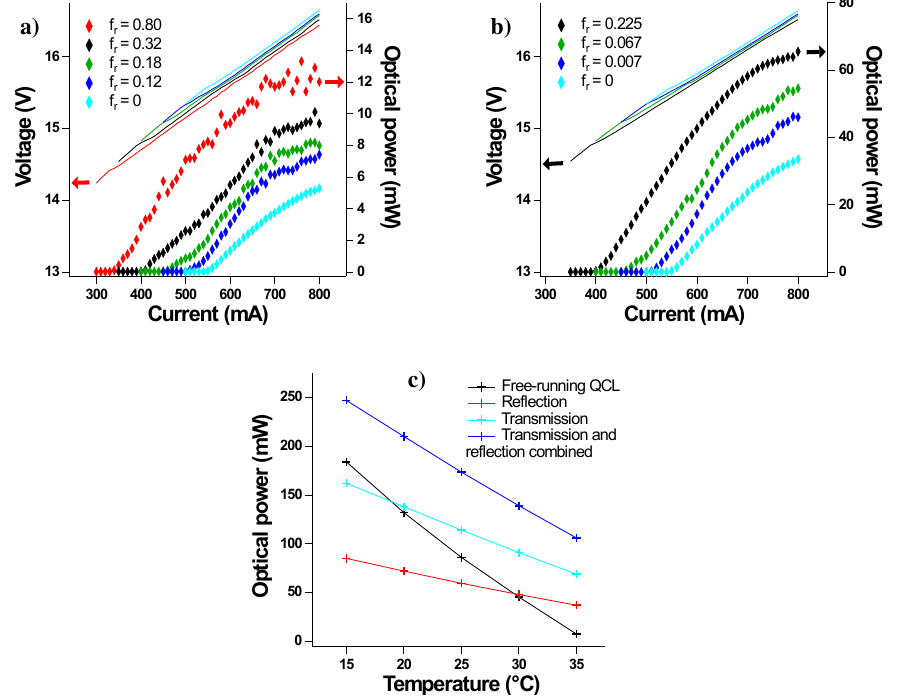
Figure 2. Analysis of the optical power emitted by the packaged QCL. ( a ) The LIV characteristic of the QCL under optical reinjection when using the platinum NPBS, and it shows a maximum threshold F IGURE 1 : a) trace temporelle expérimentale et b) spectre RF de l’onde TM émise par le LCQ lorsque la contre- reduction of 36% at f r = 0.80 compared with the free-running case. ( b ) The LIV characteristic of the réaction optique est appliquée sans retournement de polarisation. Dans ce cas, il n’y a pas de dynamique TE. QCL under optical reinjection when using the CaF 2 NPBS; the threshold reduction was 27%, though the maximum f r was only 0.24. ( c ) Maximum power that can be extracted from the external cavity when the setup of Figure 1c is used, showing extended conditions of operation for the packaged